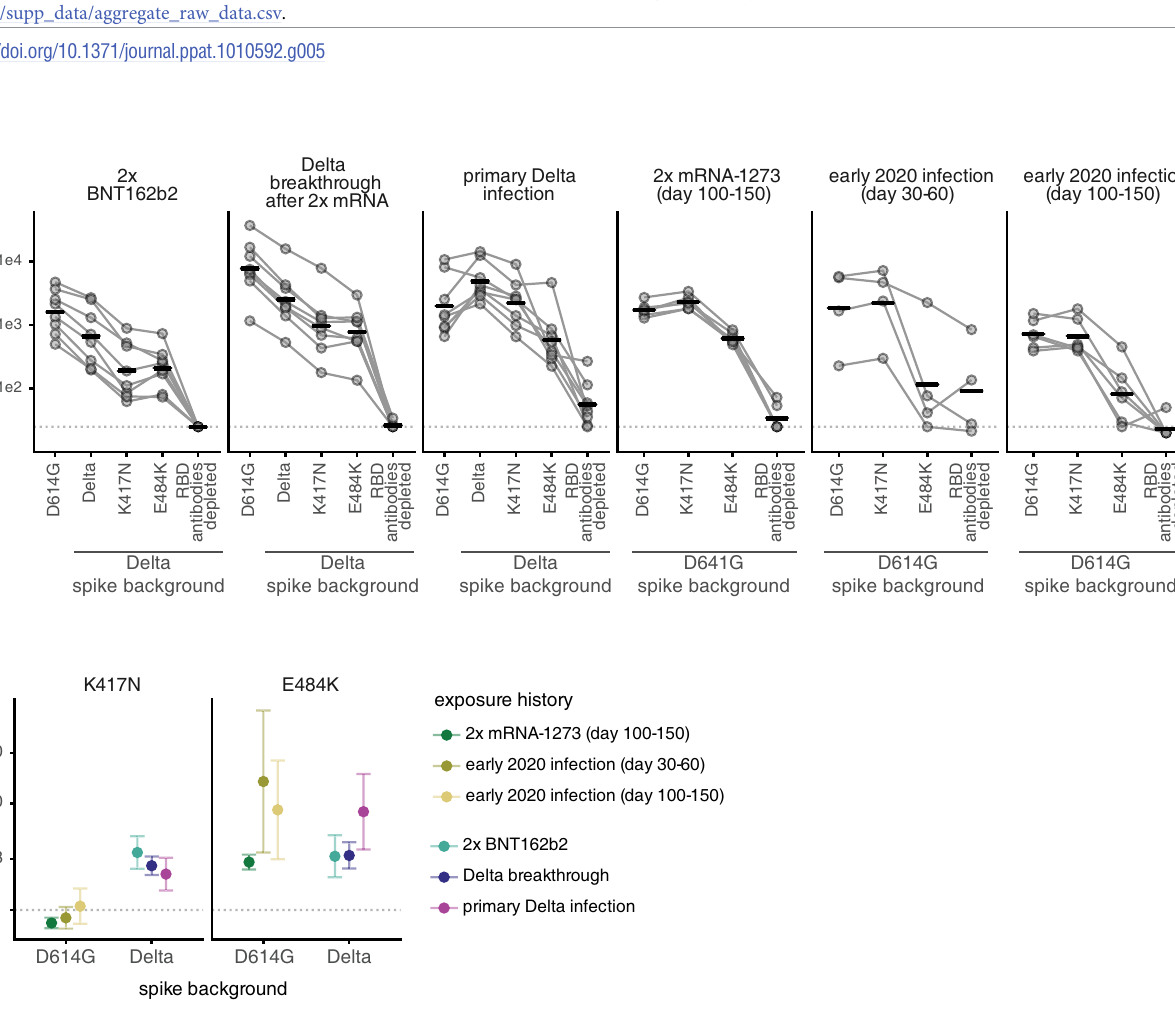
Fig 6. Effect of mutations on neutralization by antibodies elicited by 2x BNT162b2 vaccination, Delta breakthrough after 2x mRNA vaccination, or primary Delta infection. (A) Neutralization titer 50% (NT50) of spike-pseudotyped lentiviral particles by sera or plasmas from individuals with various exposure histories. The leftmost spike is D614G, which was circulating in 2020. The point mutations and depletion of RBD-binding antibodies are in the indicated spike background (D614G or Delta). Bars represent geometric mean. Dashed line indicates assay limit of detection. (B) Fold-decrease in neutralization by sera or plasmas from individuals with various exposure histories against K417N (left) or E484K (right) in the Delta and D614G spikes, compared to the homologous spike (dashed line at 1). Points represent the geometric mean across cohorts (NT50s plotted in (A)). Error bars represent geometric standard deviation. The neutralization assays with 2x BNT162b2, Delta breakthrough, and Delta primary infection were newly performed in this study, and assays with 2x mRNA-1273 and early 2020 plasmas were performed in [12,29] and are reanalyzed here. Full neutralization curves are in S7 Fig and numerical NT50s are in S1 Data and online at https://github.com/jbloomlab/SARS-CoV-2-RBD_Delta/blob/main/experimental_data/results/neut_titers/ combined_neut_titers.csv.